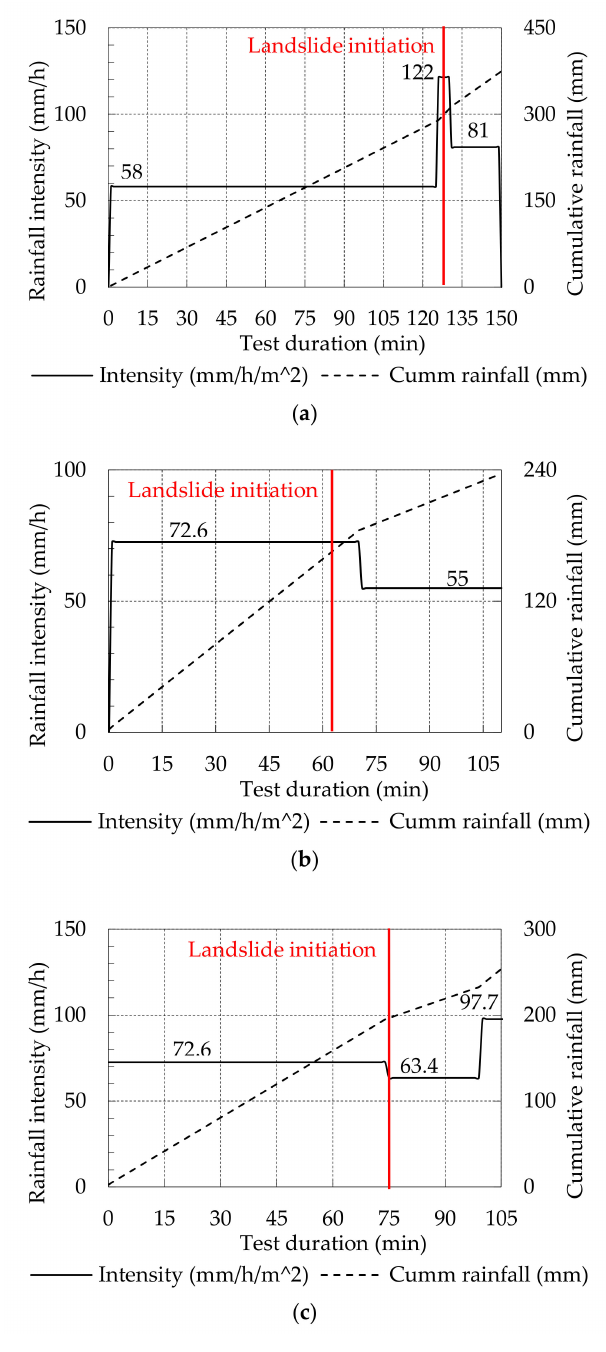
Figure 15. Diagrams of rainfall intensity during the tests with slope inclination at: ( a ) 30 ◦ ; ( b ) 35 ◦ ; ( c ) 40 ◦ . The antecedent rainfall conditions are reflected in the initial water content (or pore water pressure) distribution at the beginning of the rainfall event. In physical tests with small-scale landslide models, material is usually placed to achieve the desired initial dry density and water content conditions. For slopes consisting of sandy soils, as is the case here, tests are typically conducted starting with a low initial gravimetric soil water content (e.g., 2% in Tests 1, 2, and 3). Reduced water content results in increased matric suction in a small-scale sandy slope, resulting in an increase in effective stress and soil shear strength. At the same time, the reduced water content decreases the hydraulic conductivity of the sandy slope with respect to the water phase. In this sense, the initial water content distribution affects both the hydraulic and mechanical response of the